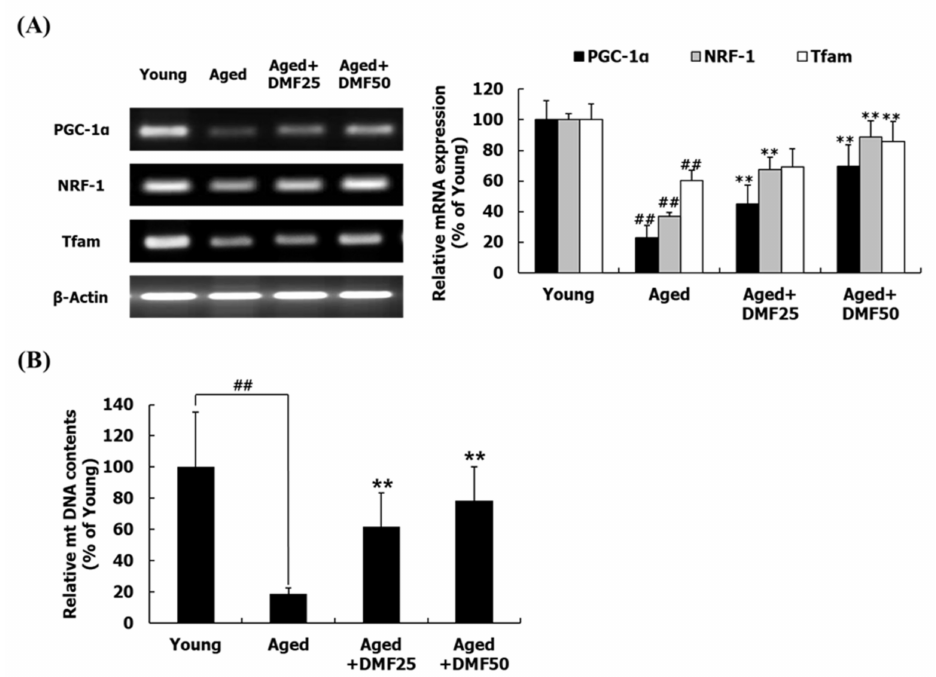
Figure 6. E ff ect of DMF on mitochondrial biogenesis in the soleus muscle. ( A ) Relative mRNA levels of PGC-1 α , NRF-1, and Tfam. ( B ) Relative mtDNA contents. Results are presented as mean ± SD; ## p < 0.01 vs. Young group; ** p < 0.01 vs. Aged